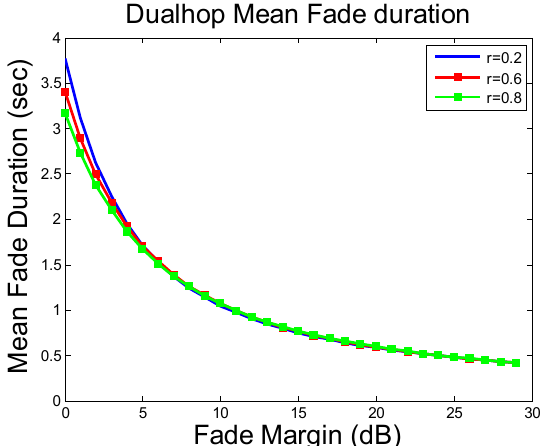
Figure 4. Theoretical and simulated average outage duration for a regenerative dual-hop link vs. fade margin.